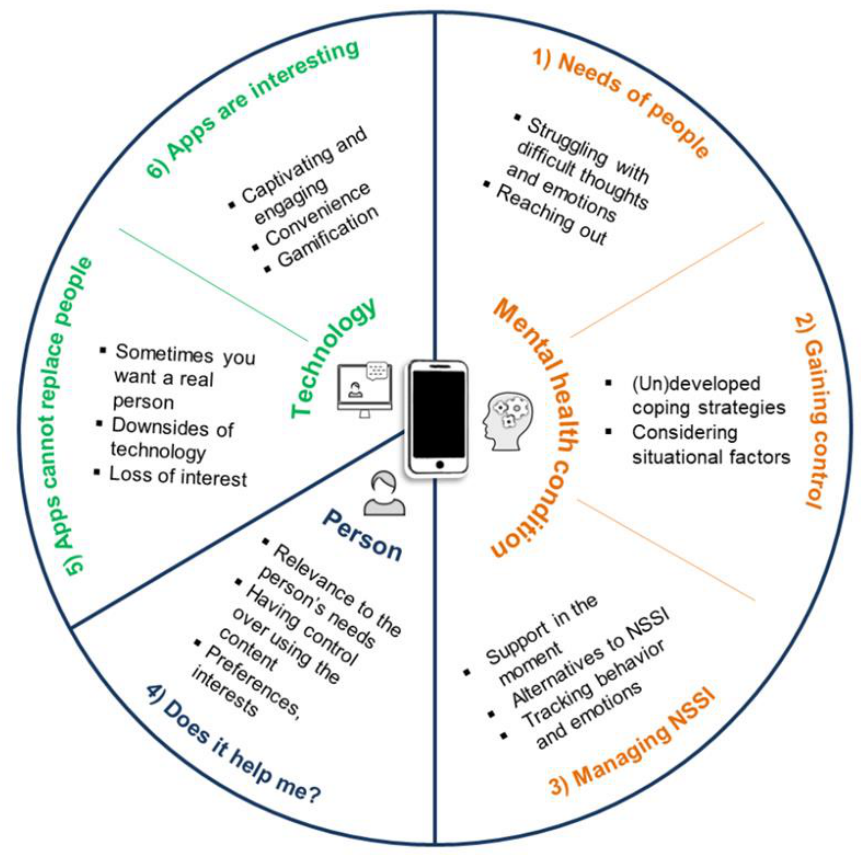
Figure 2. Framework for designing engaging digital mental health interventions derived from the context of NSSI.